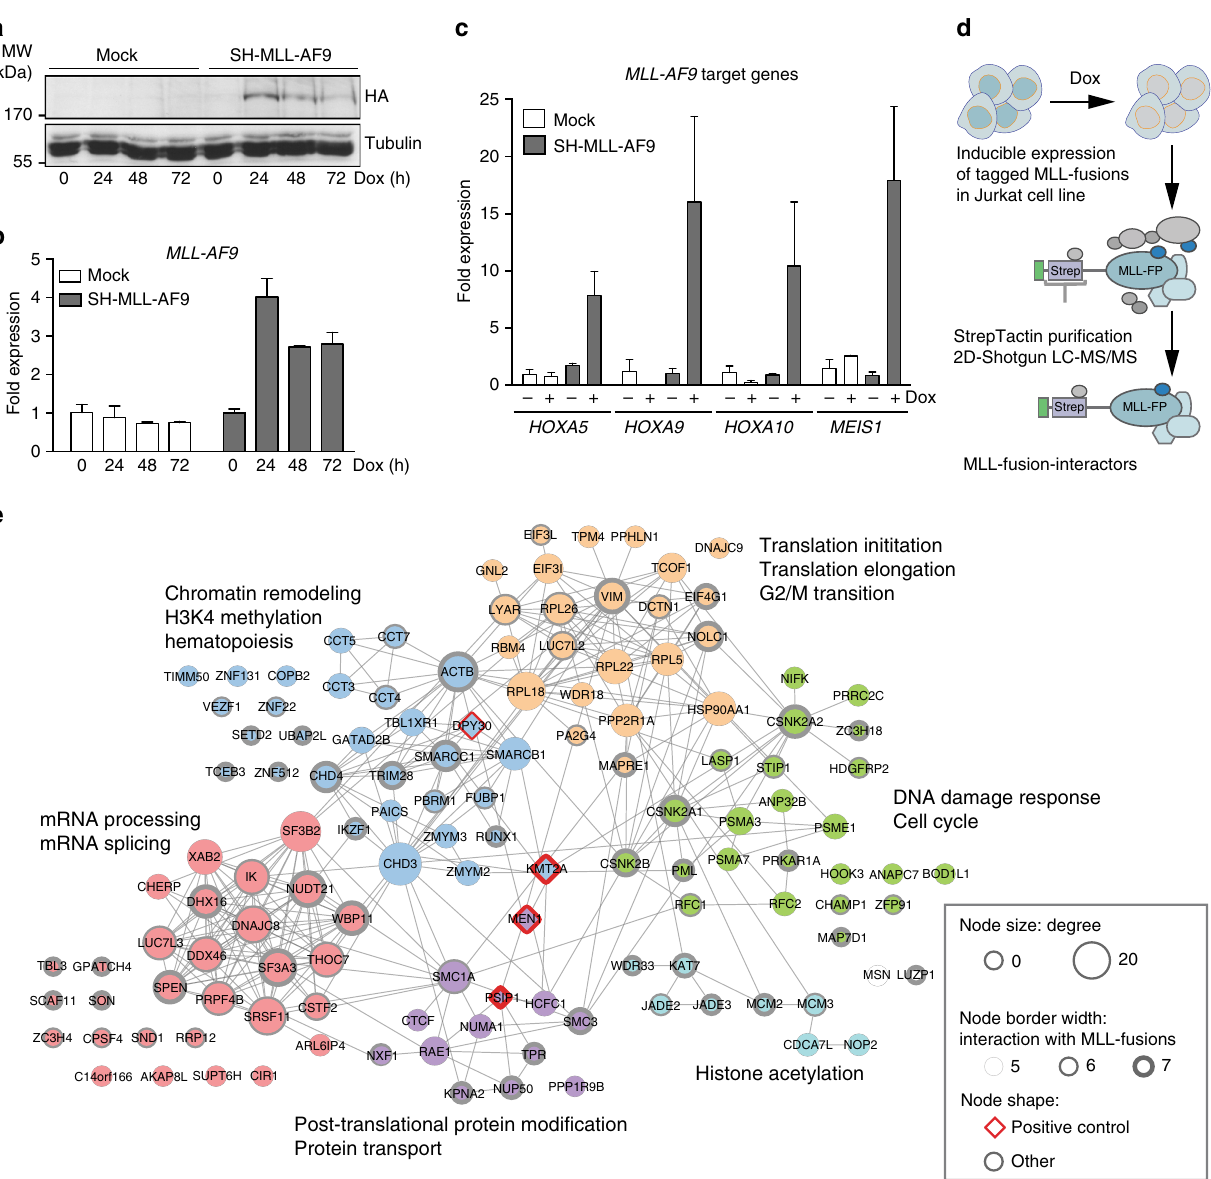
Fig. 1 Functional proteomic survey of the MLL-fusion interactome. Cells expressing Strep-HA (SH)-tagged MLL-AF9 or mock-transfected cells were treated with Dox for the indicated time points and transgene expression was monitored by immunoblotting ( a ) and qPCR ( b ) (means ± s.d. n = 3). c SH-MLL-AF9- expressing cells were treated with Dox for 24 h and the expression of indicated MLL-target genes was measured by qPCR (mean ± s.d. n = 3). d Schematic illustration of the strategy of af fi nity puri fi cation of protein complexes associated with MLL-fusion proteins from nuclear lysates of cell lines expressing af fi nity-tagged MLL-fusion proteins. e Gene ontology (GO) enrichment of six distinct protein communities among the core 128 interactors shared by at least 5 of 7 MLL-fusion